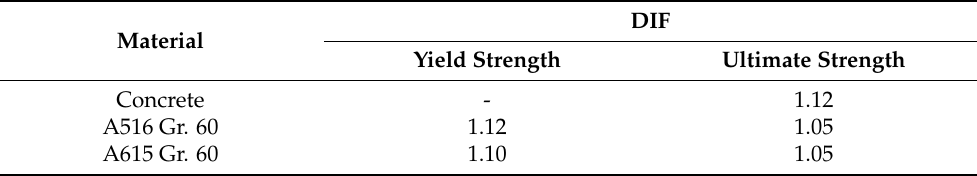
Table 4. Dynamic increase factor (DIF).